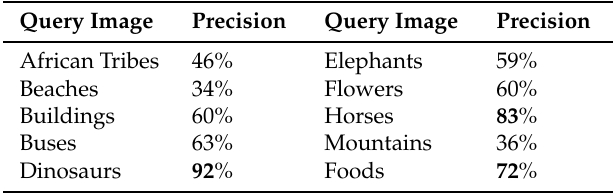
Table 3. Precision rate for retrieving the Top 20 database images for each query